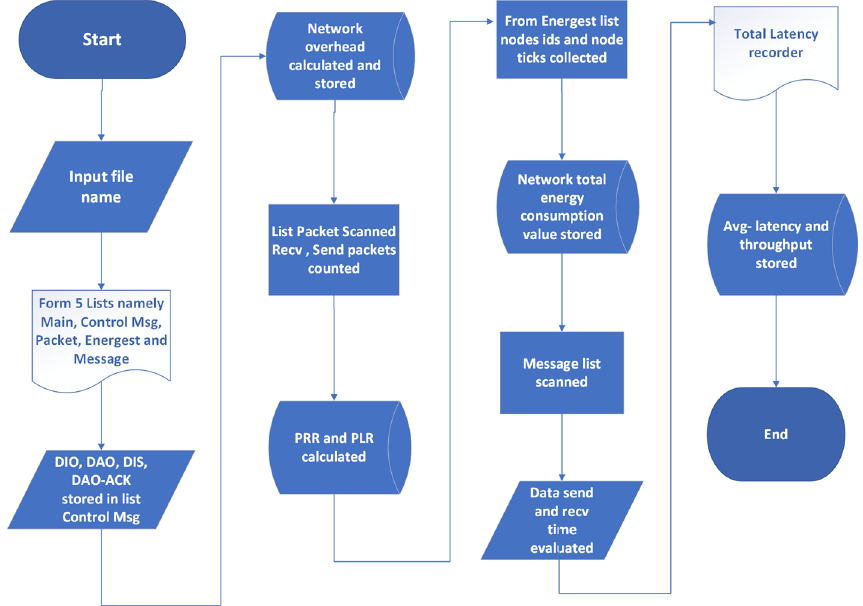
Fig. 13 Flow chart for data analysis using python